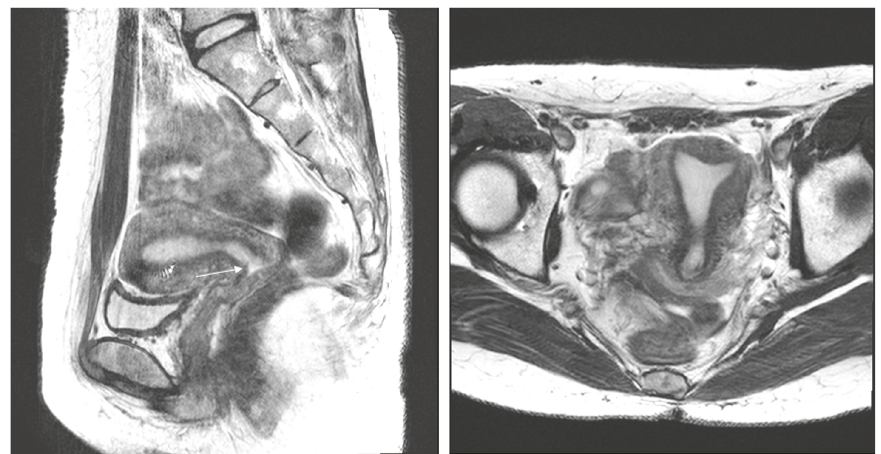
Figure 5: Stage IB1 squamous cervical carcinoma in a 28-year-old woman with trachelectomy (A) T2-weighted axial and (B) sagittal MR images show no gross cancerous lesion of uterine cervix but a tissue defect (arrow) after conization. At histopathological finding, 1.2 cm sized invasive squamous cell carcinoma in uterine cervix was found. MRI stage T0 was underdiagnosed as final pathologic stage